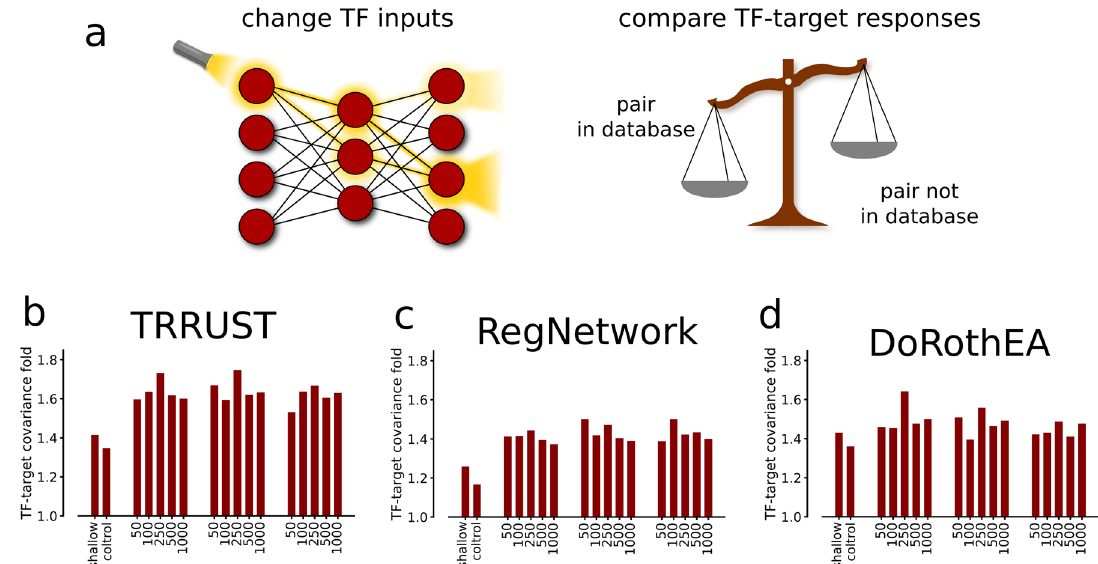
Fig. 3 Node light-up reveals known TF-target associations. a By applying a light-up analysis, i.e. by changing the input values of each TF independently and subsequently observing the changes on the output layer, we were able to estimate how the TF-to-target mappings corresponded to TF bindings known from literature. We de fi ned the TF-target covariance fold as the median value of the light-ups for the TF- target regulations found in a database divided by the respective backgrounds. b The light-up enrichments for the TF-target associations found in the TRRUST database are shown. Note that the expected value representing no biological relevance between TF-target mapping is 1 and that light-up values are compared to absolute Spearman rank correlation values, labeled ‘ control ’ . We performed the same analysis with RegNetwork ( c ), and the interactions annotated with top con fi dence in DoRothEA ( d